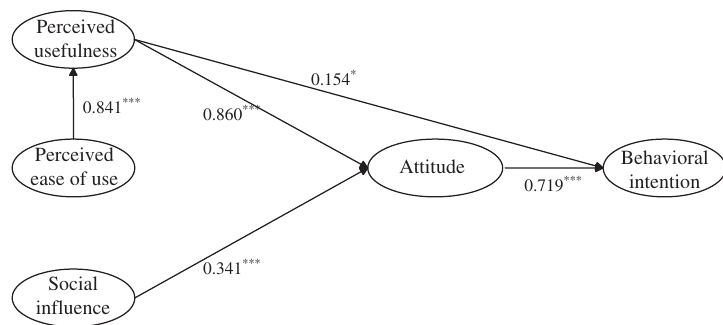
Figure 3. Path Coefficients After Modification.